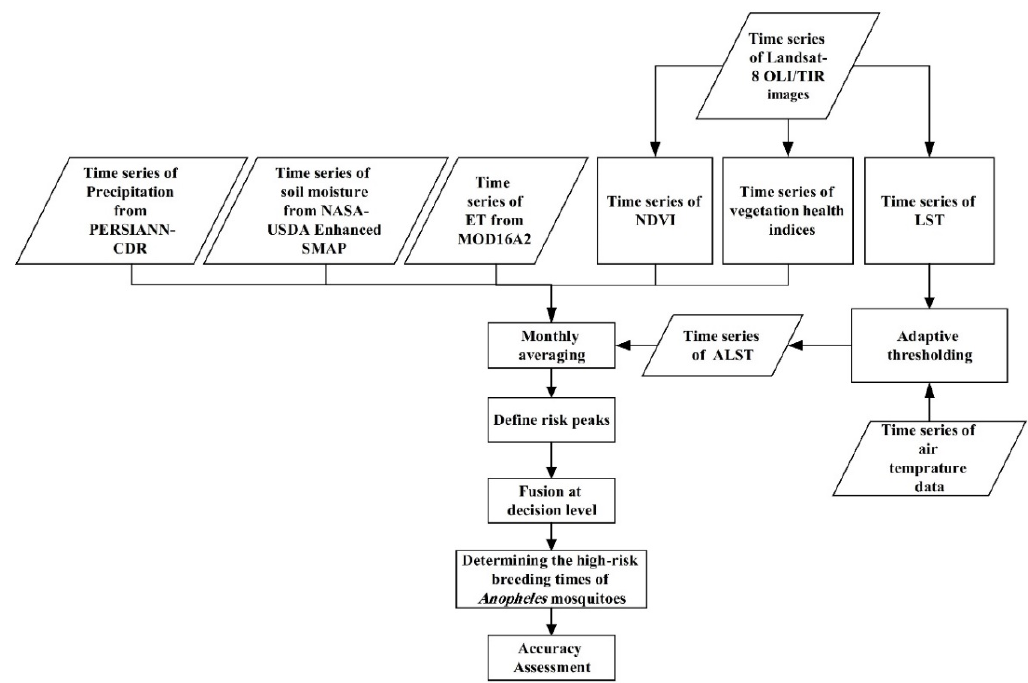
Figure 1. Flowchart of the steps of the proposed method.